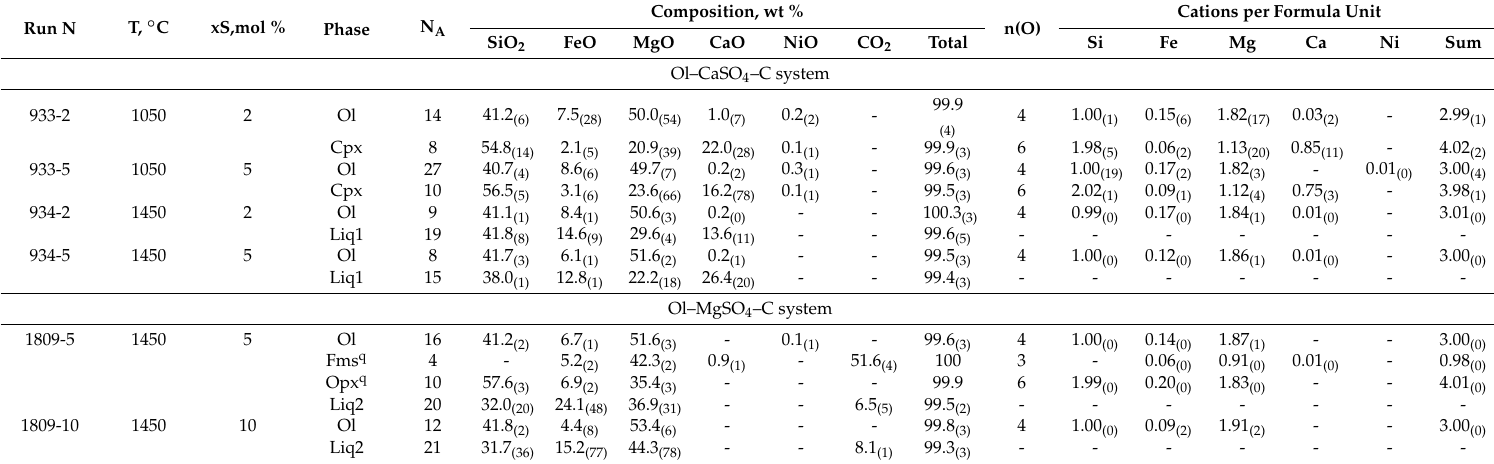
Table 3. Compositions of silicates, silicate-oxide and carbonate-silicate